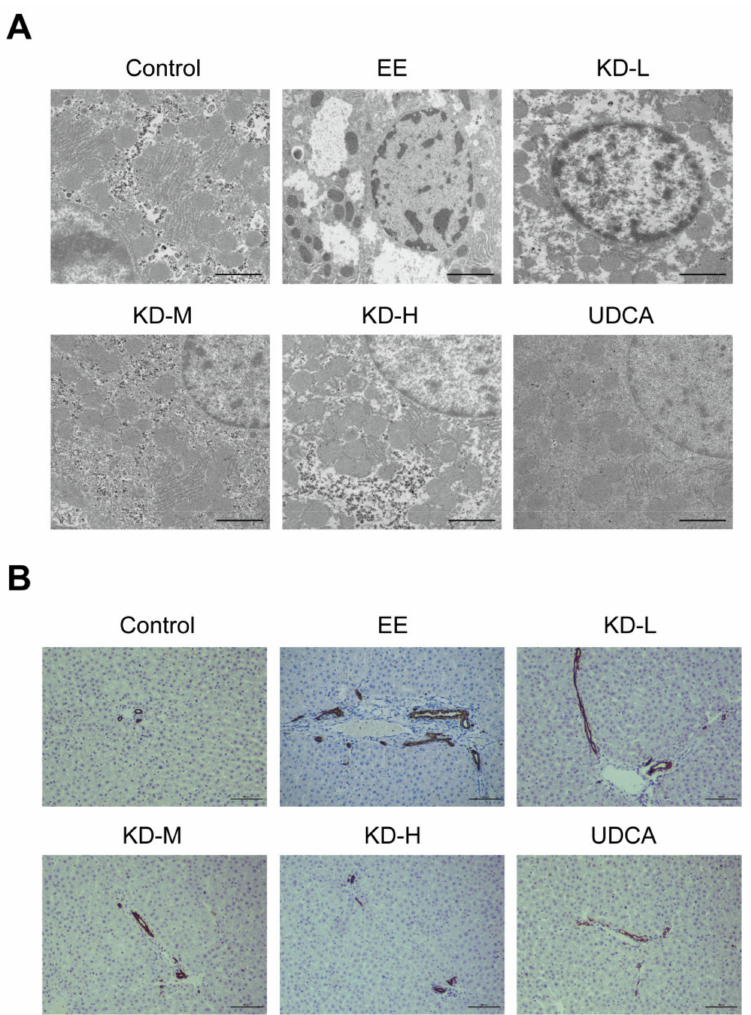
Figure 3. The effects of KD on hepatocellular microstructure and bile duct cell proliferation. ( A ) Rep- resentative images of liver in each group by TEM were analysed to assess the microstructural changes in hepatocytes. Scale bar, 2 µ m. ( B ) Representative immunohistochemical images of CK19 expressed in bile duct cells from each group were acquired to evaluate hyperplasia of the bile duct. Scale bar, 100 µ